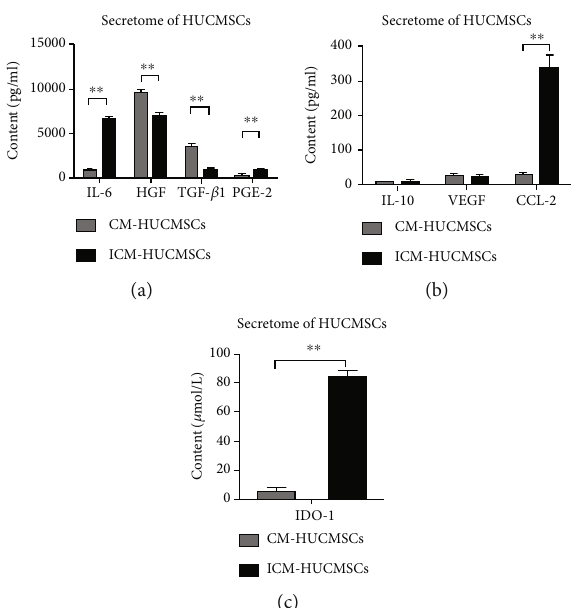
Figure 5: Analysis of several factors in the secretome of HUCMSCs. (a) ELISA results of IL-6, HGF, TGF- β 1, and PGE-2 in CM-HUCMSCs and ICM-HUCMSCs. (b) ELISA results of IL-10, VEGF, and CCL-2 in CM-HUCMSCs and ICM-HUCMSCs. (c) ELISA results of IDO-1 in CM-HUCMSCs and ICM-HUCMSCs. Data are presented as mean ± SEM . ∗ p ≤ 0 : 05 , ∗∗ p ≤ 0 : 01